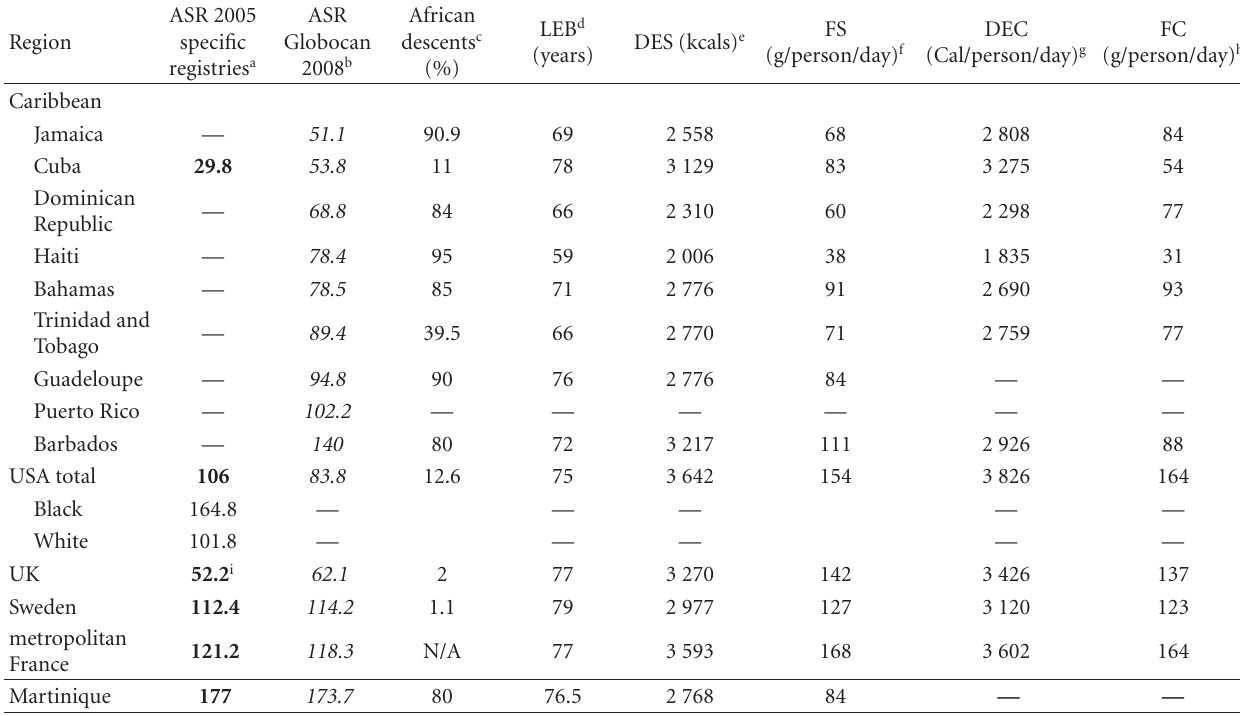
a Age-standardized rates (ASR) are per 100 000 man-year and are age-adjusted to the IARC world standard population. Data source are obtained for Cuba from the Public Health Ministry [11], for USA, from the National Cancer Institute’s Surveillance, Epidemiology and End Results (SEER) 2003–2007 [16], for UK, from the Information Services Division [12], Scotland [13] (see i), for Sweden, from the National Board of Health and Welfare [15], for metropolitan France, from the French National Sanitary Surveillance Institute (InVS) [9], and for Martinique, from AMREC [8]. b Data source for World ASR obtained from Globocan 2008 [10]. c Data source obtained from the Encyclopedia of the Nations [17], the Befolkningsstatistik [19], and the O ffi ce by National Statistics [18], for the Caribbean area, Sweden, and UK, respectively. The Caribbean people living in UK represent 1% of the overall population. For France, data are not available (N/A)